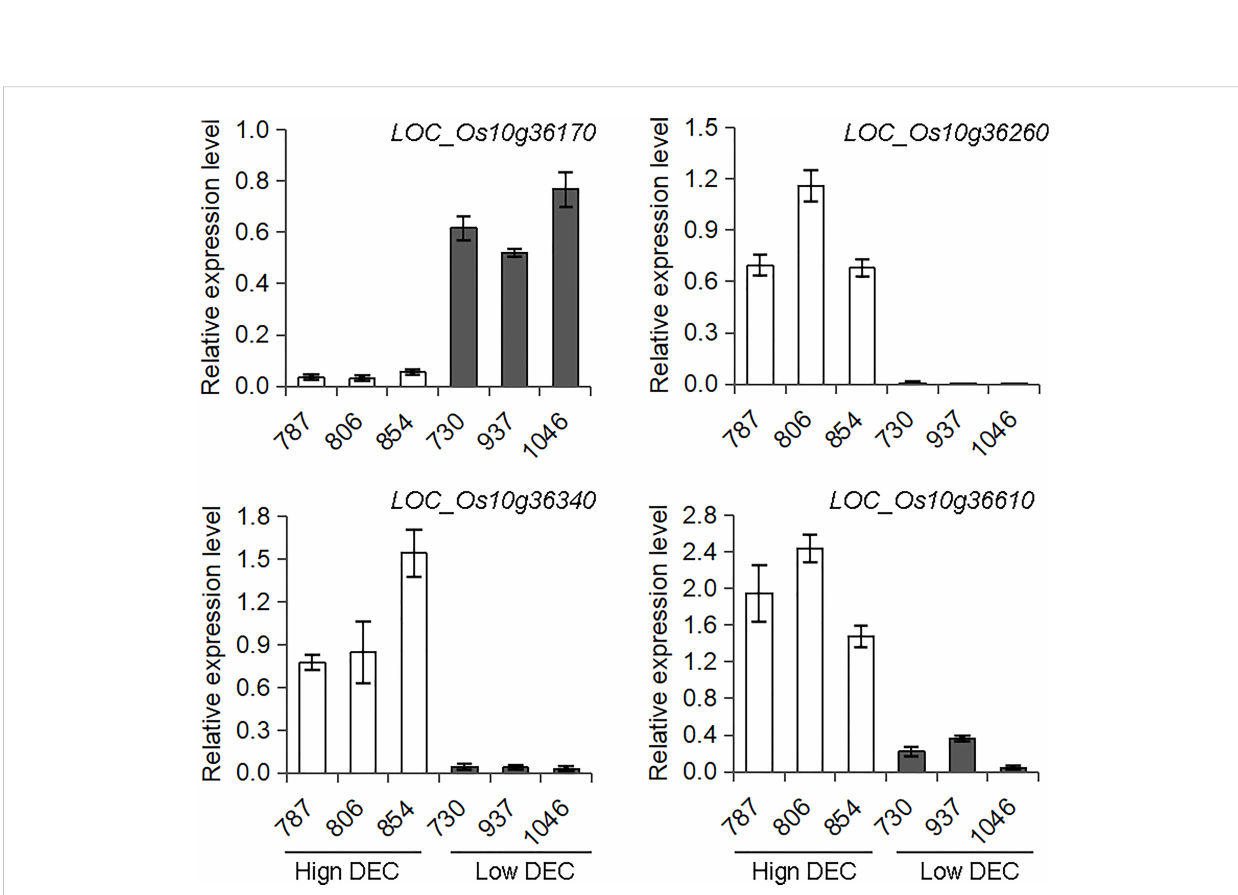
FIGURE 4 Expression analysis of candidate genes for qDEC-10c 1w,2wj . The spikes were sampled on the15th day after fl owering of three accessions with high DEC (accessions 787, 806 and 854) and three accessions with low DEC (accessions 730, 937 and 1046) were selected based on haplotype analysis to conduct RNA-sequencing and qRT-PCR. Different letters indicate signi fi cant difference at P <